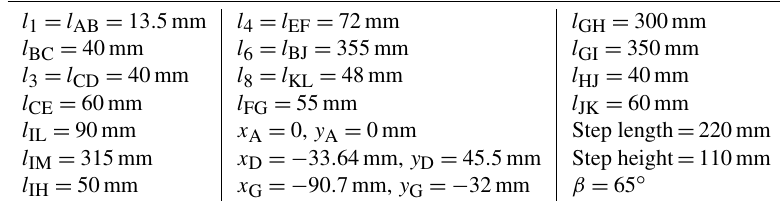
Figure 15. Dynamic model of leg exoskeleton for simulation: (a) ADAMS model; (b) foot ground contact in ADAMS. Table 1. Design parameters of leg mechanism.